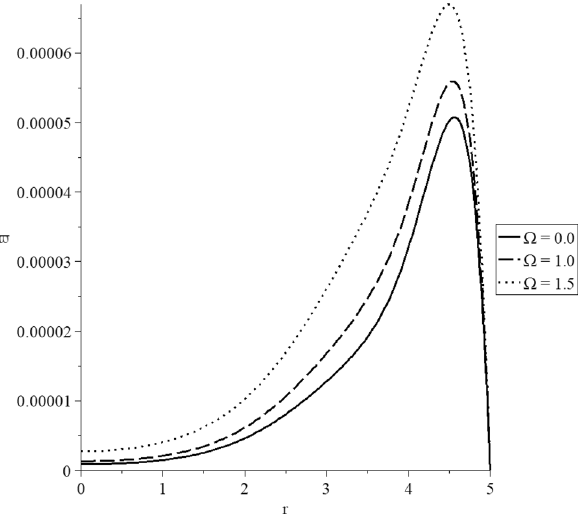
Figure 20. The stress-strain energy distribution with various values of the angular velocity of the rotation